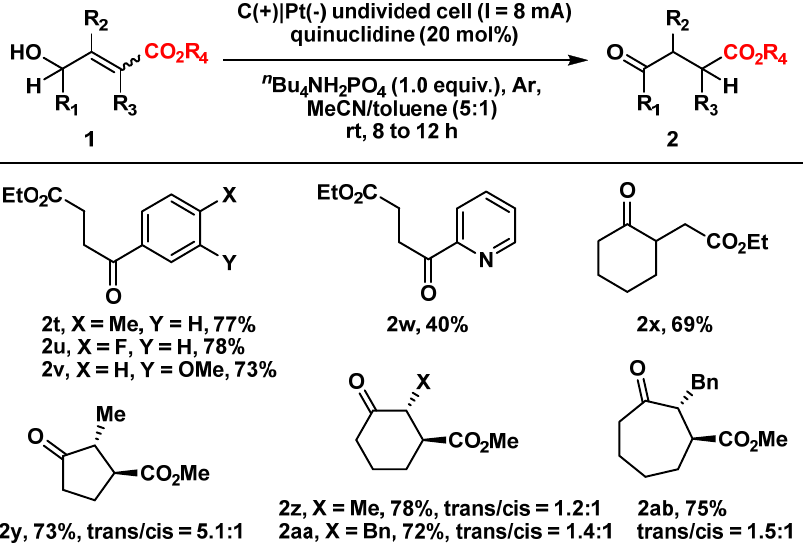
Figure 3. Substrate scope of γ -carbonyl-allylic alcohols. Reactions were conducted at a 0.5 mmol scale using standard reaction conditions. All tri-substituted allylic alcohol substrates were E-isomers. The trans/cis ratios of the products were determined by 1 H-NMR spectra.